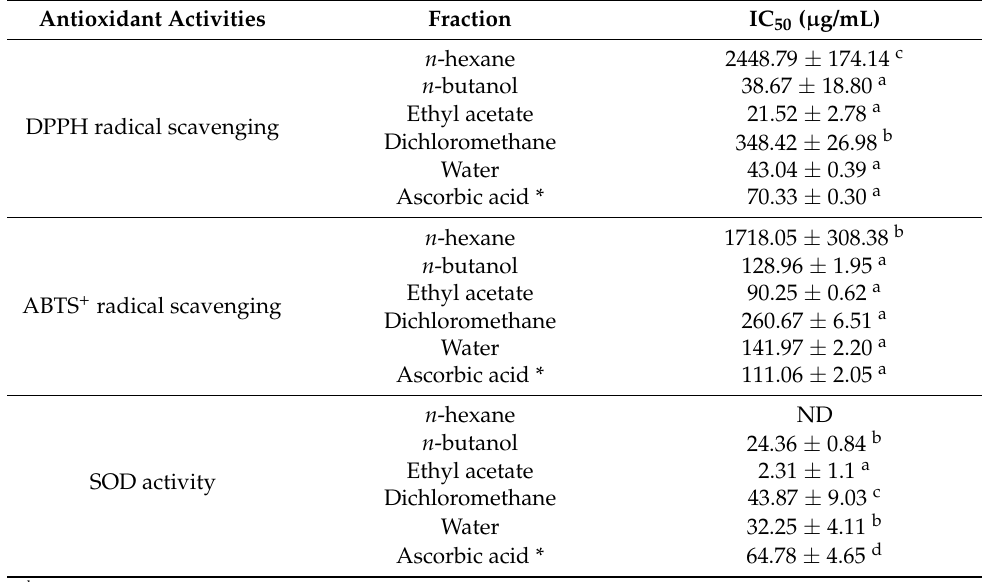
Table 2. Radical scavenging and antioxidant activity of R. emodi using different solvent